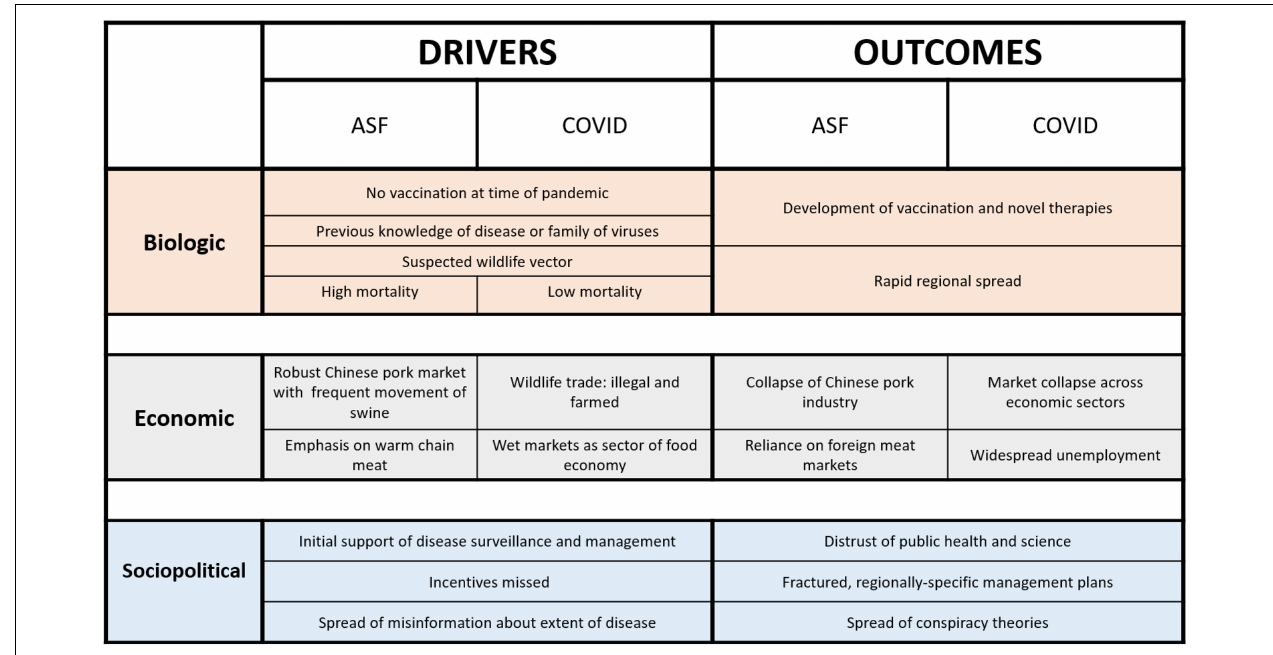
FIGURE 1 | Drivers and outcomes of ASF and COVID have animal, human, and environmental health implications. This comparative framework identifies commonalities and predictable aspects of One Health